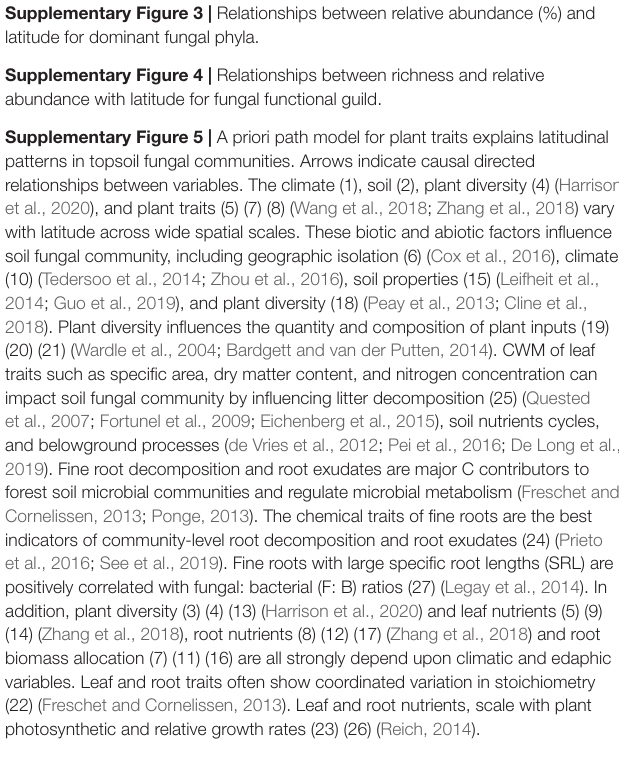
Supplementary Figure 2 | Relative abundances of the dominant fungal classes. Supplementary Figure 3 | Relationships between relative abundance (%) and latitude for dominant fungal phyla. Supplementary Figure 4 | Relationships between richness and relative abundance with latitude for fungal functional guild. Supplementary Figure 5 | A priori path model for plant traits explains latitudinal patterns in topsoil fungal communities. Arrows indicate causal